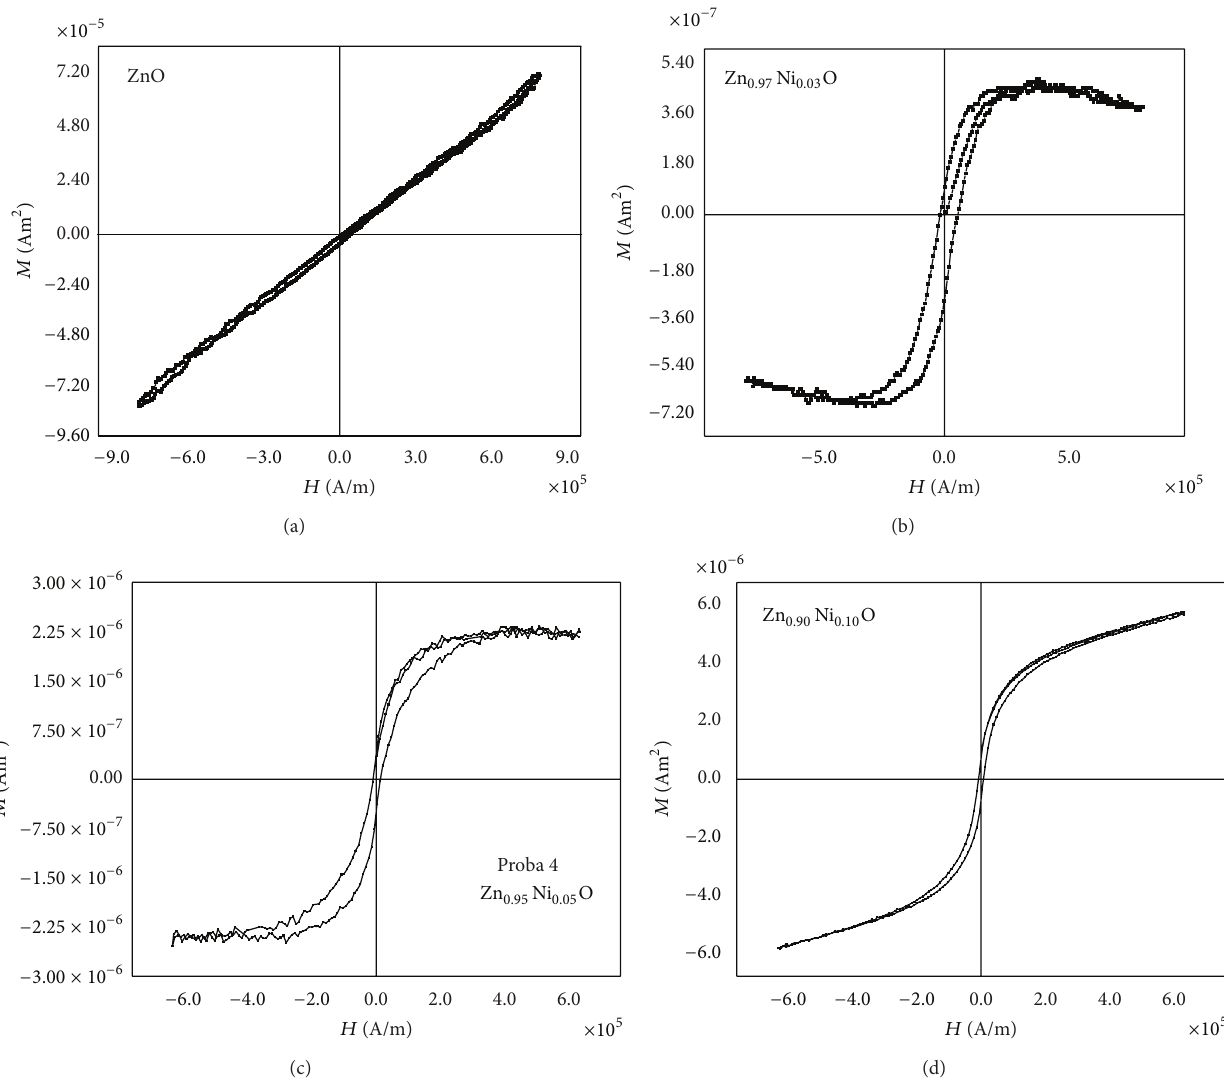
Figure 5: Magnetic hysteresis curves of (a) ZnO, (b) Zn 0.97 Ni 0.03 O, (c) Zn 0.95 Ni 0.05 O, and (d) Zn 0.90 Ni 0.10 O thin films.